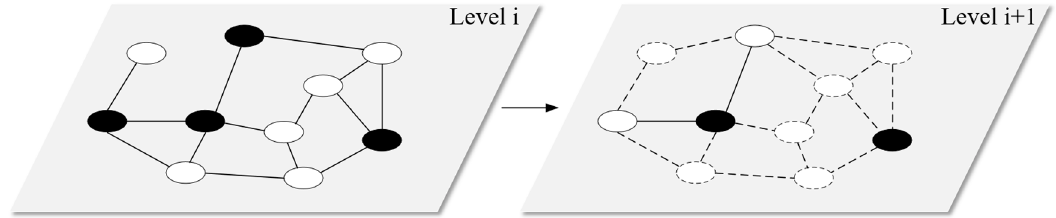
Figure 3. An example operation in IIT-UP. The network of each layer is solved in order from low to high. The HMs in the level 𝑖 layer constitute the topology of the level 𝑖 + 1 layer.